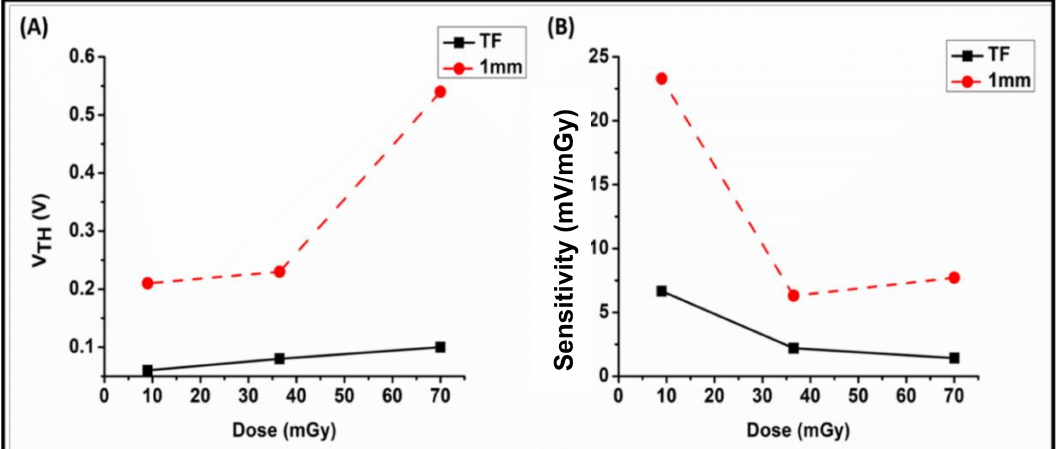
Figure 6. ( A ) Threshold voltage vs. dose and ( B ) sensitivity vs. dose for the ZnO-Pb thin film and disks irradiated with the low